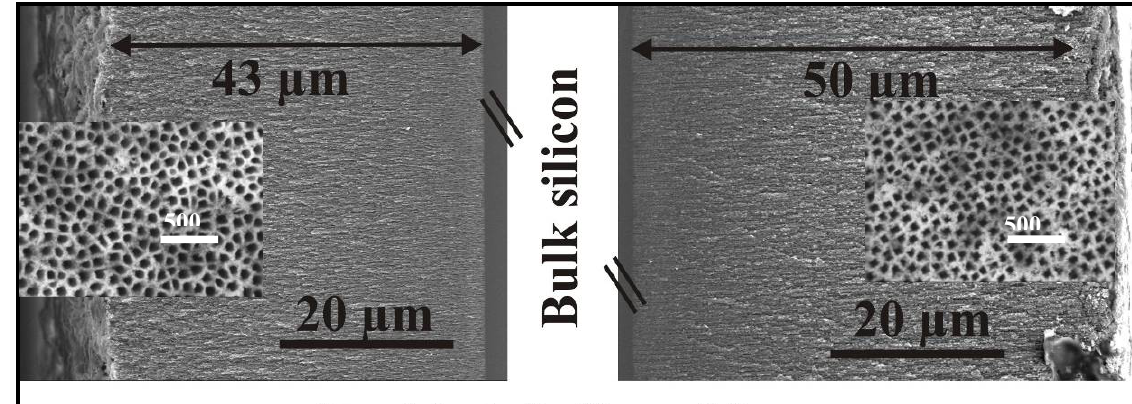
Figure 14. Cross-sectional and corresponding plan view of the surfaces (inset) of the two porous